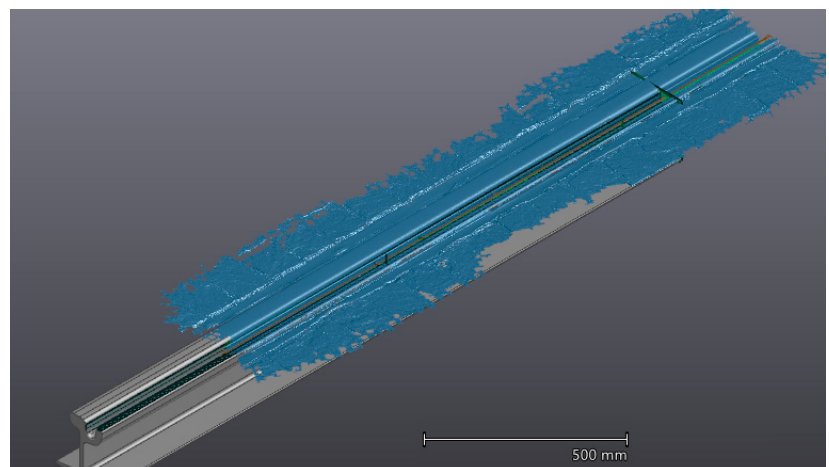
Figure 15. Automatic alignment. Sensors 2020 , 20 , x FOR PEER REVIEW